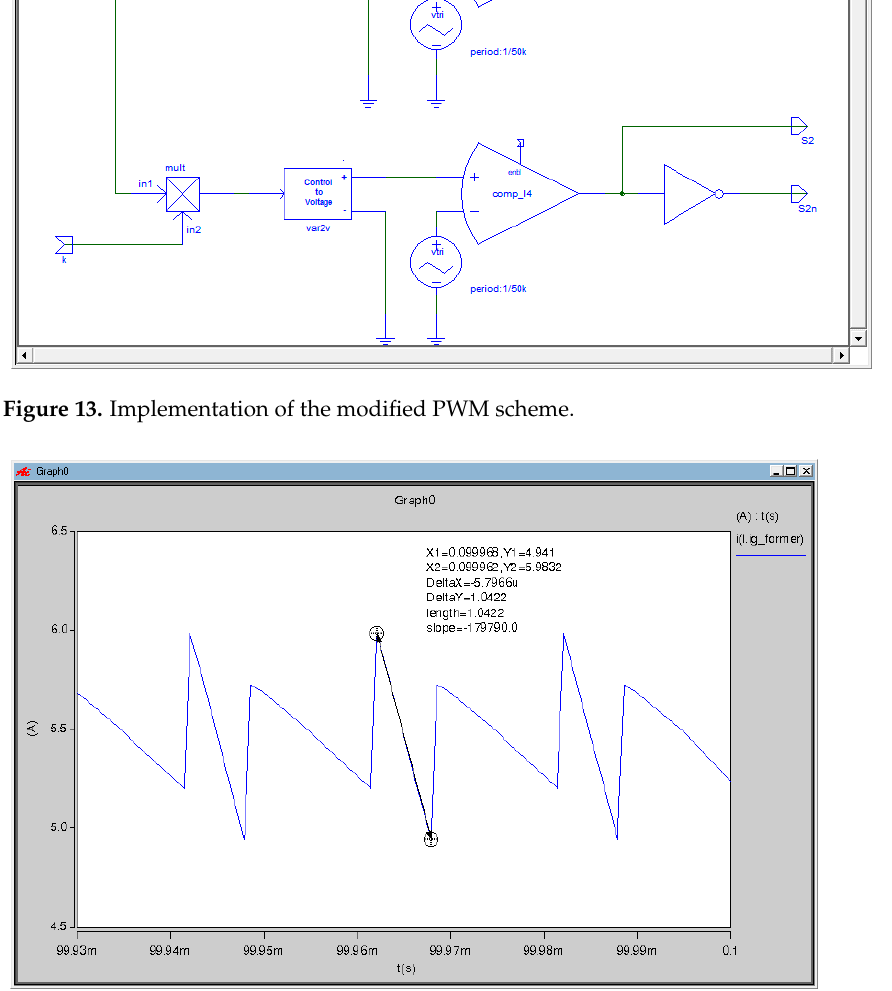
Figure 13. Implementation of the modified PWM scheme.